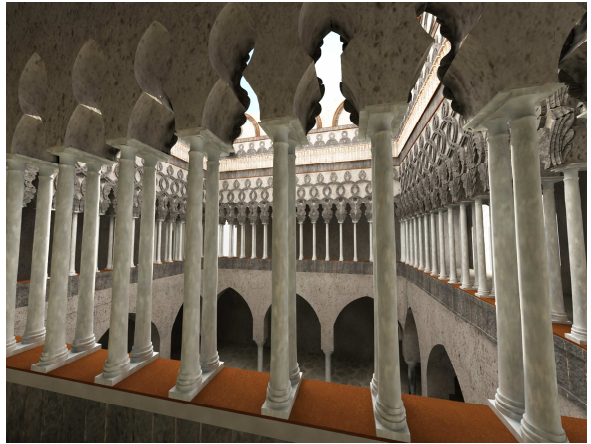
Figure 10. Rendering of the virtual model reconstruction assume similar in forms and height, greater than that of the ambulatory (as is recorded at the lower level);